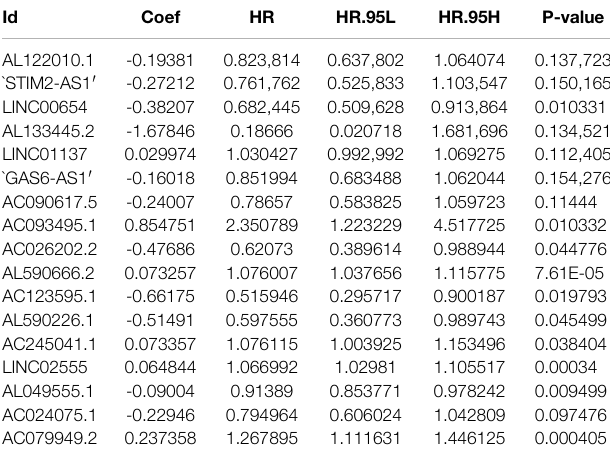
TABLE 6 | Multivariate Cox regression analysis of m 6 A-related lncRNAs in